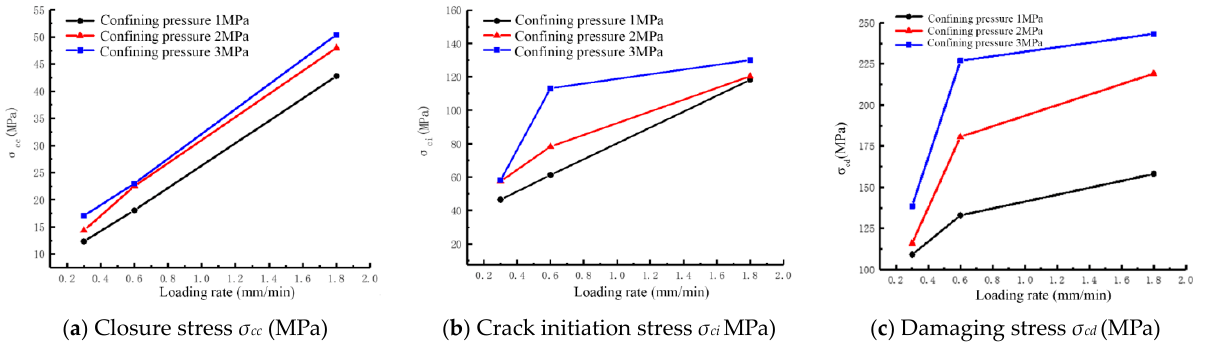
Figure 8. Characteristic stress curves of specimens.